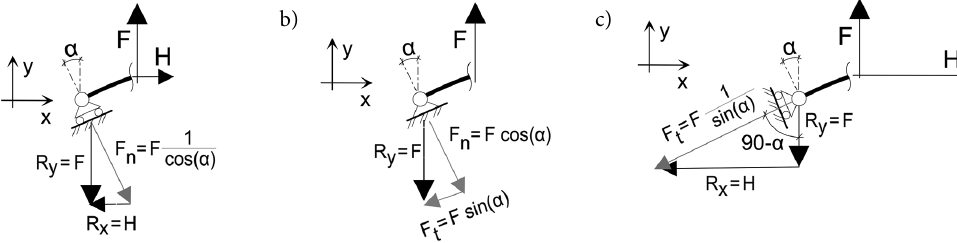
Figure 4. Support reactions: a – horizontally sliding support; b – pinned support; c – vertically